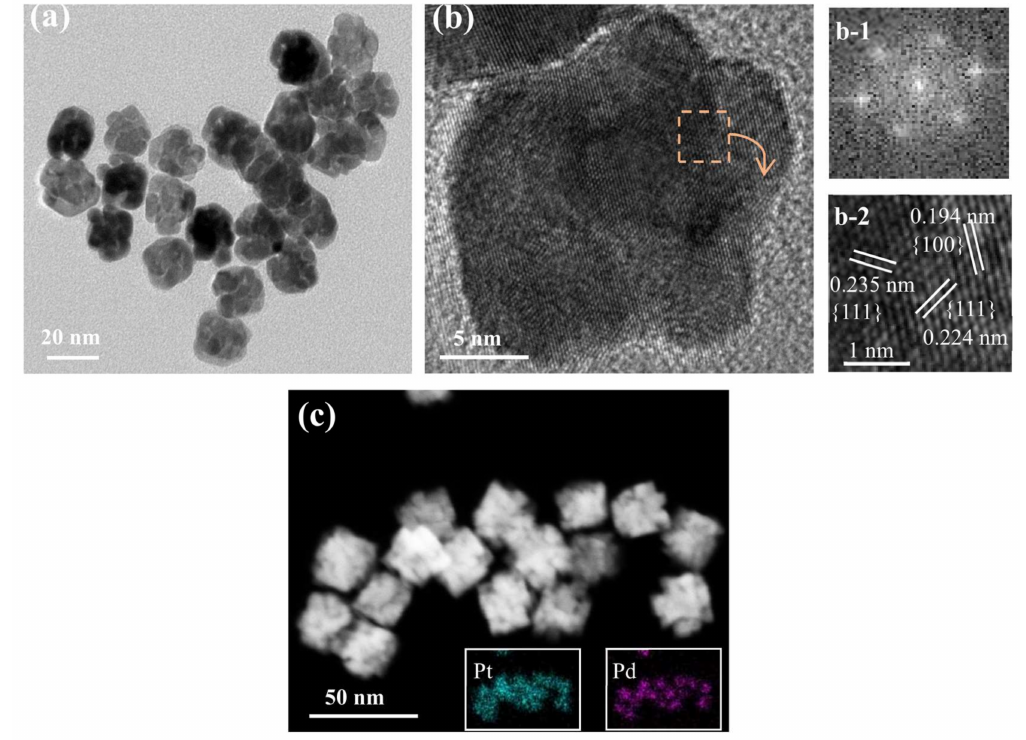
Figure 1. Morphology and composition analyses for the porous Pt–Pd nanoparticles synthesized at 190 ◦ C: ( a ) Representative low-magnification TEM image, ( b ) high-magnification TEM image, ( b-1 ) the corresponding Fourier transform (FFT) pattern, ( b-2 ) the corresponding magnified TEM image, ( c ) high-angle annular dark-field scanning TEM (HADDF-STEM) image. The insets in ( c ) show the corresponding elemental mapping images of Pt (blue) and Pd (red) for porous Pt–Pd nanoparticles.